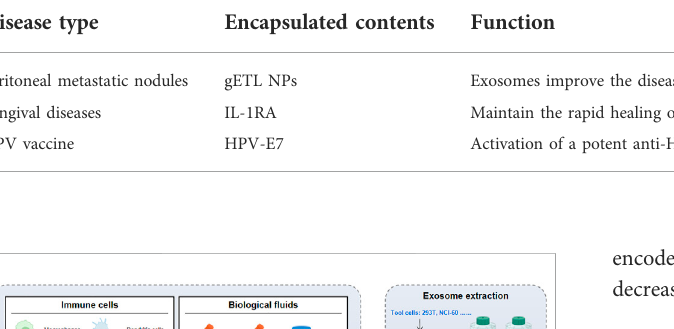
TABLE 11 Engineered exosomes in the other diseases.